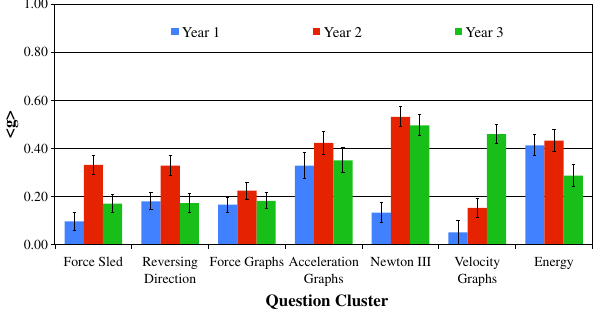
FIG. 3. Normalized gains for school 1 for each question cluster on the FMCE. Error bars are the standard error of the gain.